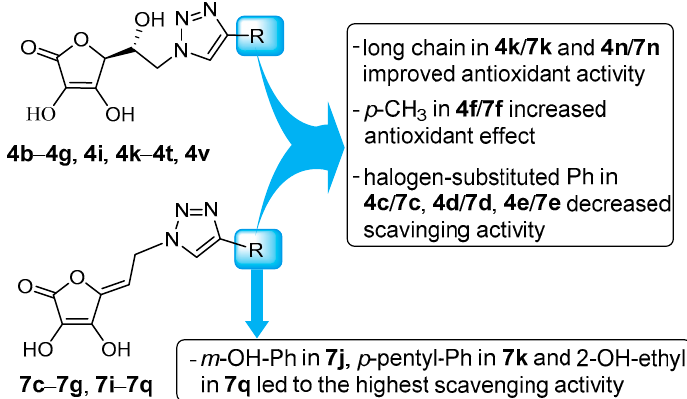
Figure 1. Summarized representation of the importance of some structural features in antioxidant/radical-scavenging activity. The arrows point to structure-activity observations.